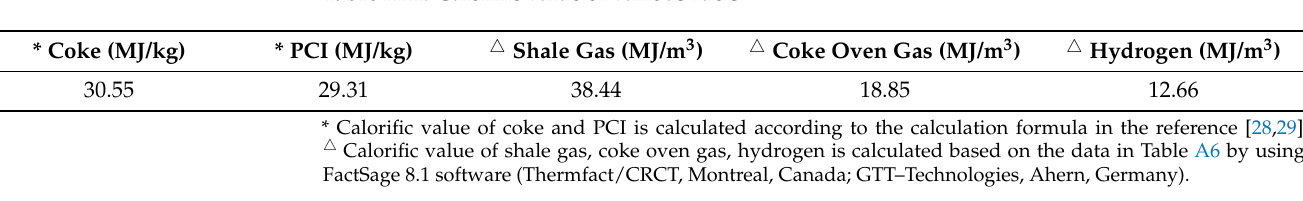
Table A11. Calorific value of various